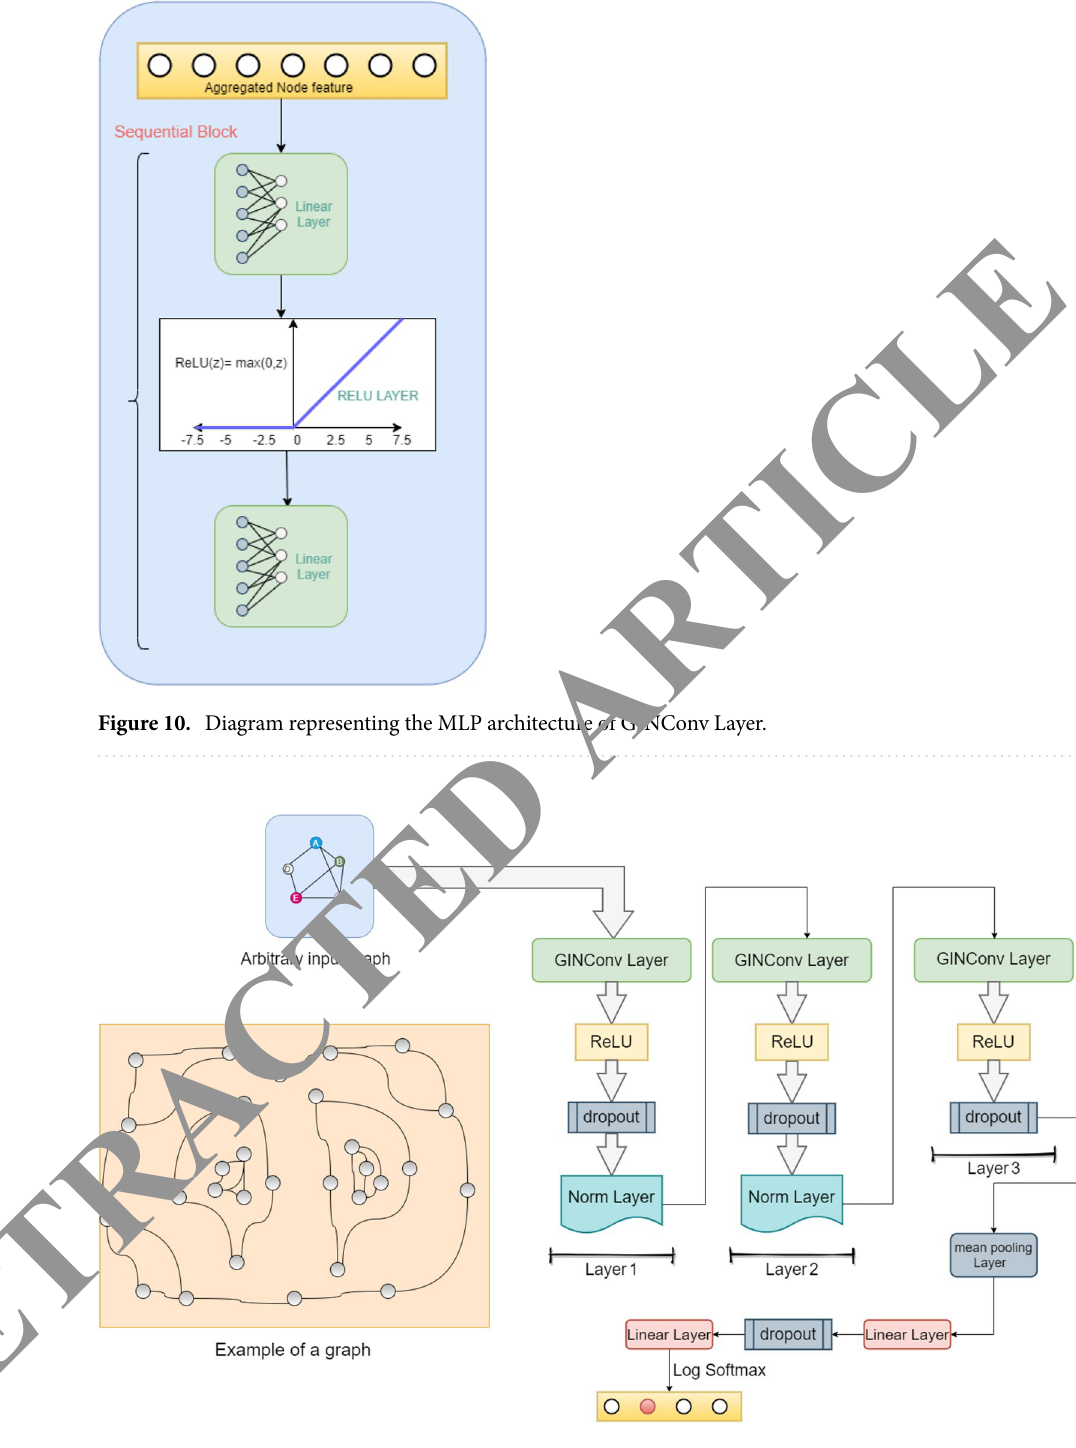
Figure 11. Overall architecture of our proposed GraphCovidNet